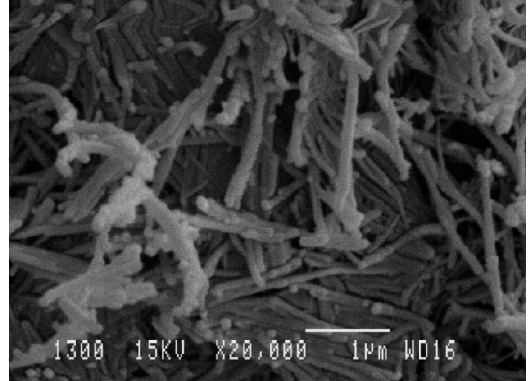
Figure 7. Sepiolite SEM.